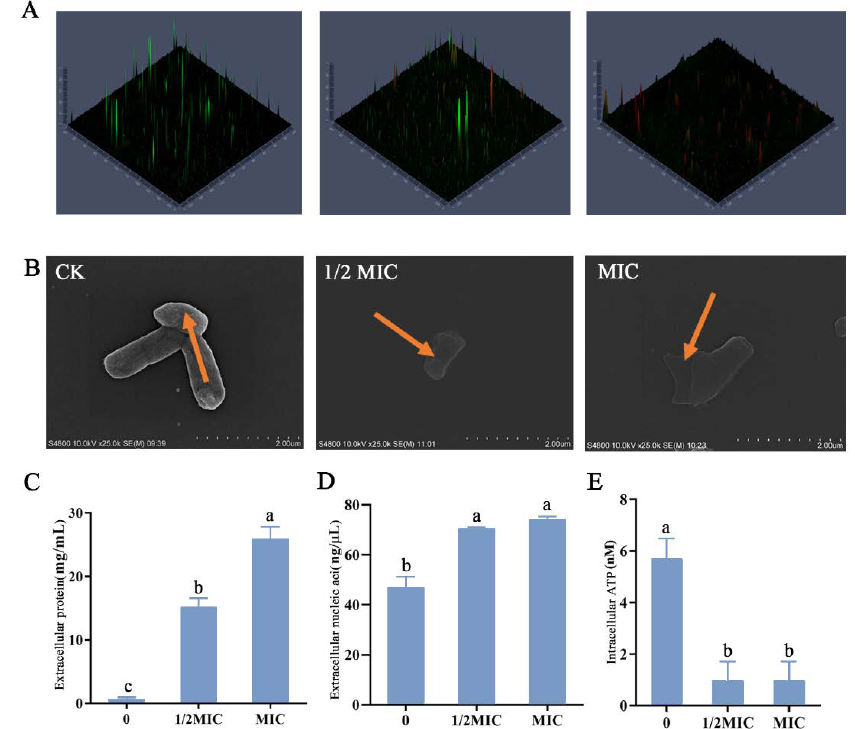
Figure 5. Cell damage of C. sakazakii ATCC 29544. CLSM showed C. sakazakii viability treated with different concentrations of thymol. ( A ) Cells stained with propidium iodide (PI) are labeled red, whereas cells stained with SYTO9 are labeled green. ( B ) Scanning electron micrographs of C. sakazakii ATCC 29544 treated with different concentrations of thymol. ( C ) Extracellular protein concentration. ( D ) Extracellular nucleic acid concentration. ( E ) Intracellular ATP concentration. Different lowercase letters (a, b, c) above bars indicate significant differences ( p < 0.05).